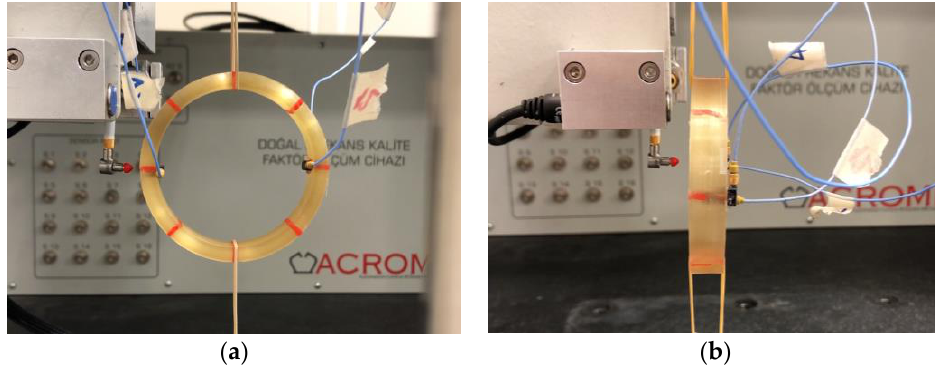
Figure 2. The free-free boundary condition for the modal test.